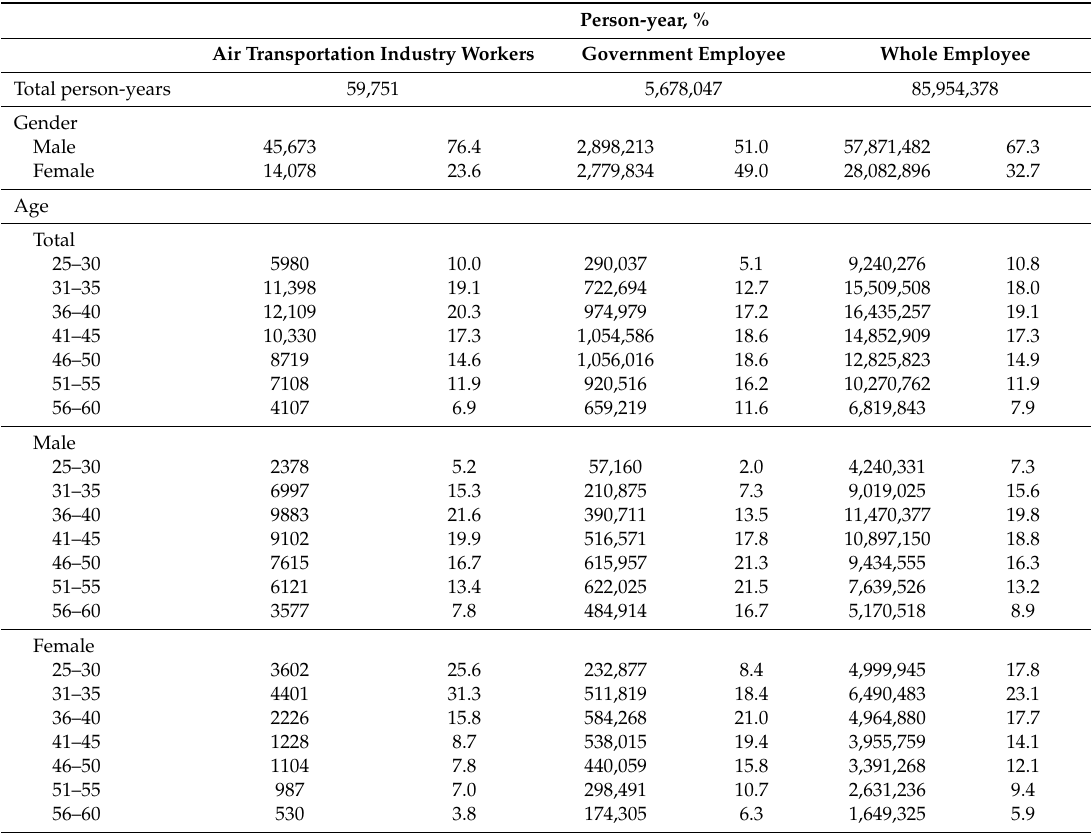
Table 1. The characteristics of the study participants at the baseline of